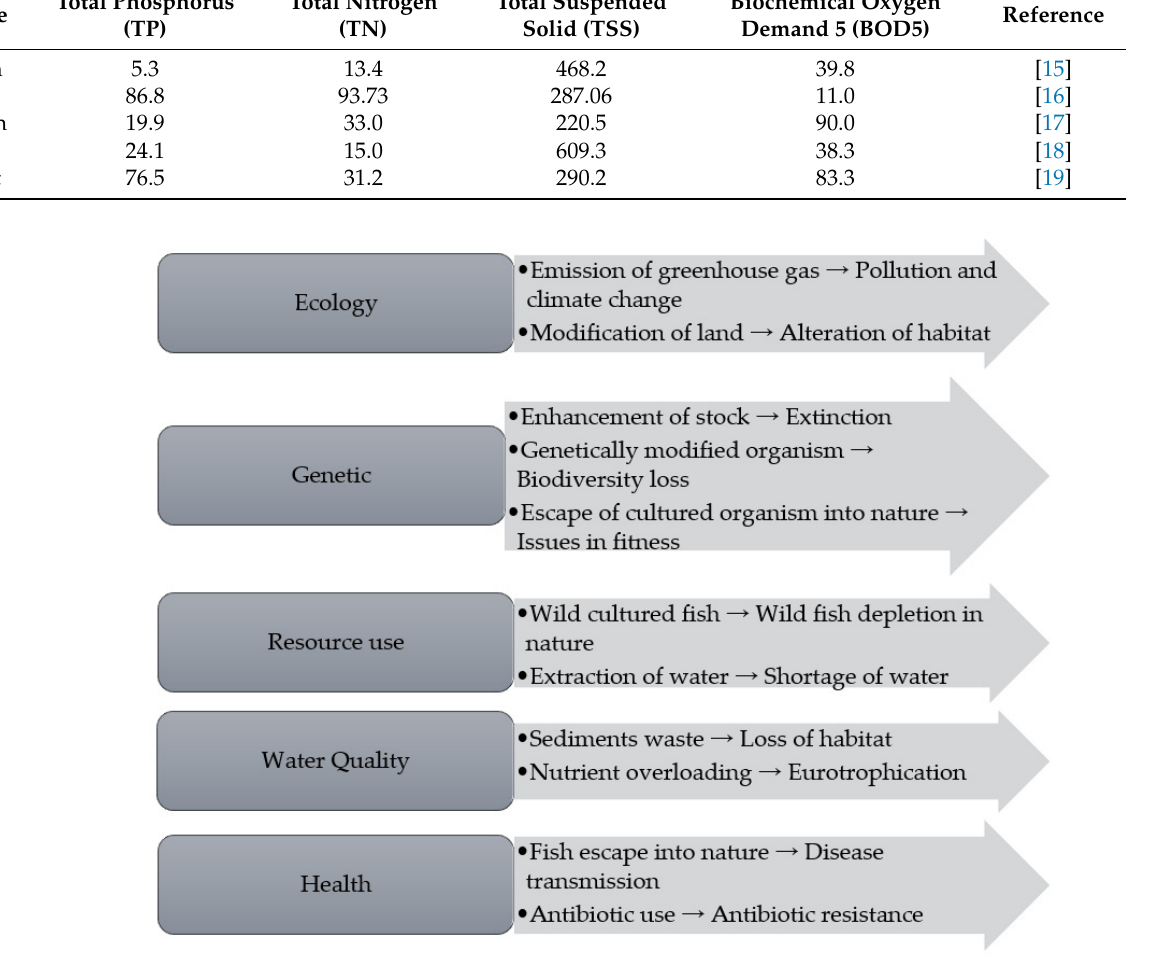
Figure 1. Threats resulting from the aquaculture sector towards the